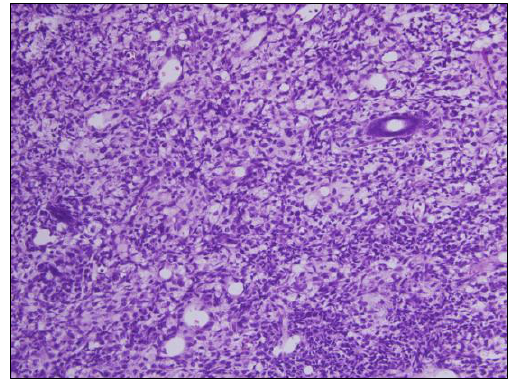
Figure 2: Histopathology showing classical Wilms’ tumor